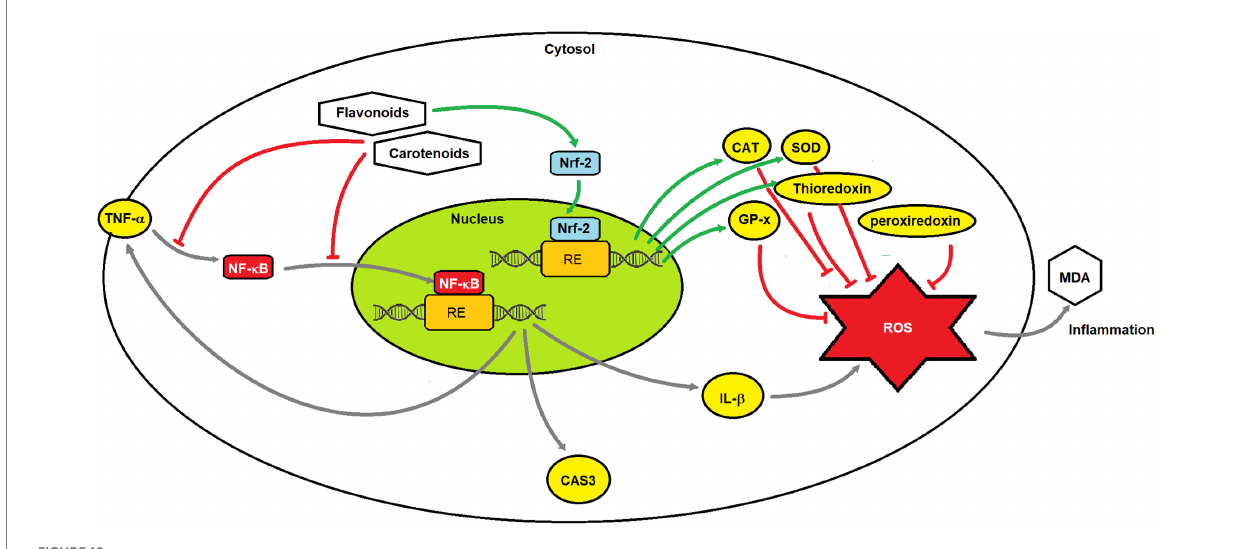
FIGURE 19 Mechanisms of the anti-inflammatory effect of flavonoids and